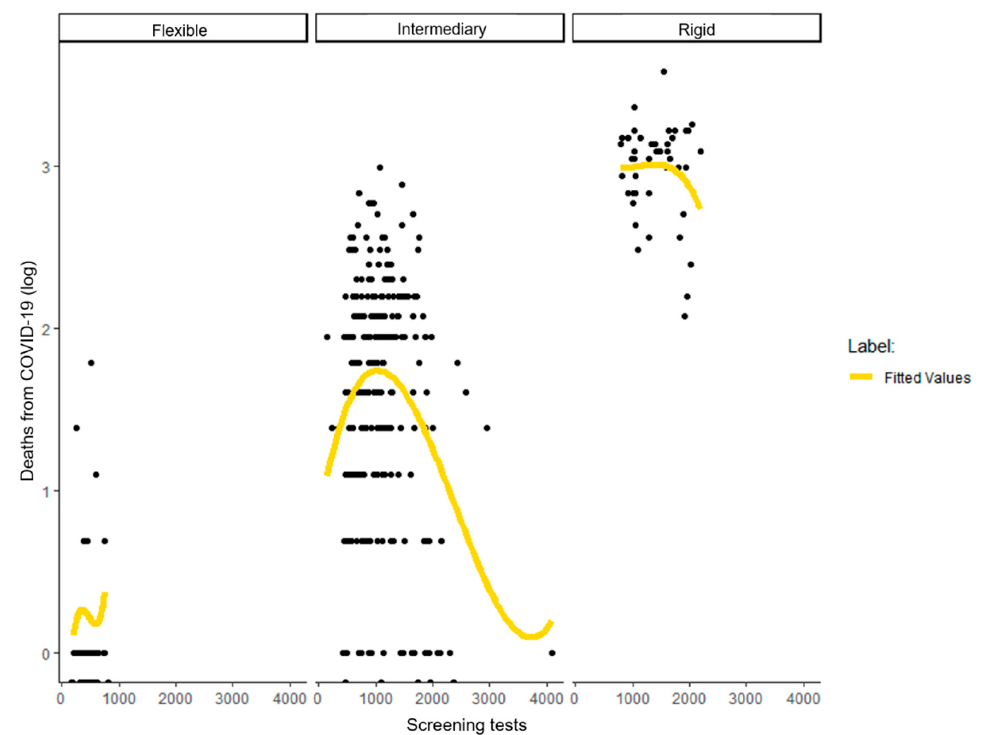
Figure 5. Behavior of deaths by COVID-19 notified to the Municipal Health Department of Uberlândia (MG), according to phases of the municipal plan and screening tests performed. (MG), according to phases of the municipal plan and screening tests